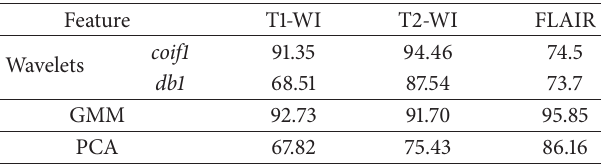
∗ db1 and coif1 are the first order of Daubechies and Coiflet wavelet, respectively. Table 4: Comparison of area under (%) ROC curve between three feature